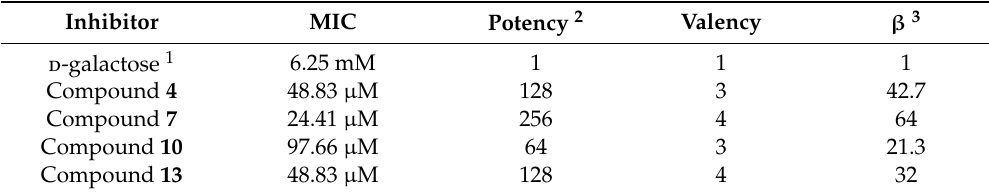
Table 1. The MIC (minimal inhibitory concentration) values and potencies of tested inhibitors obtained for the inhibition of hemagglutination caused by lectin